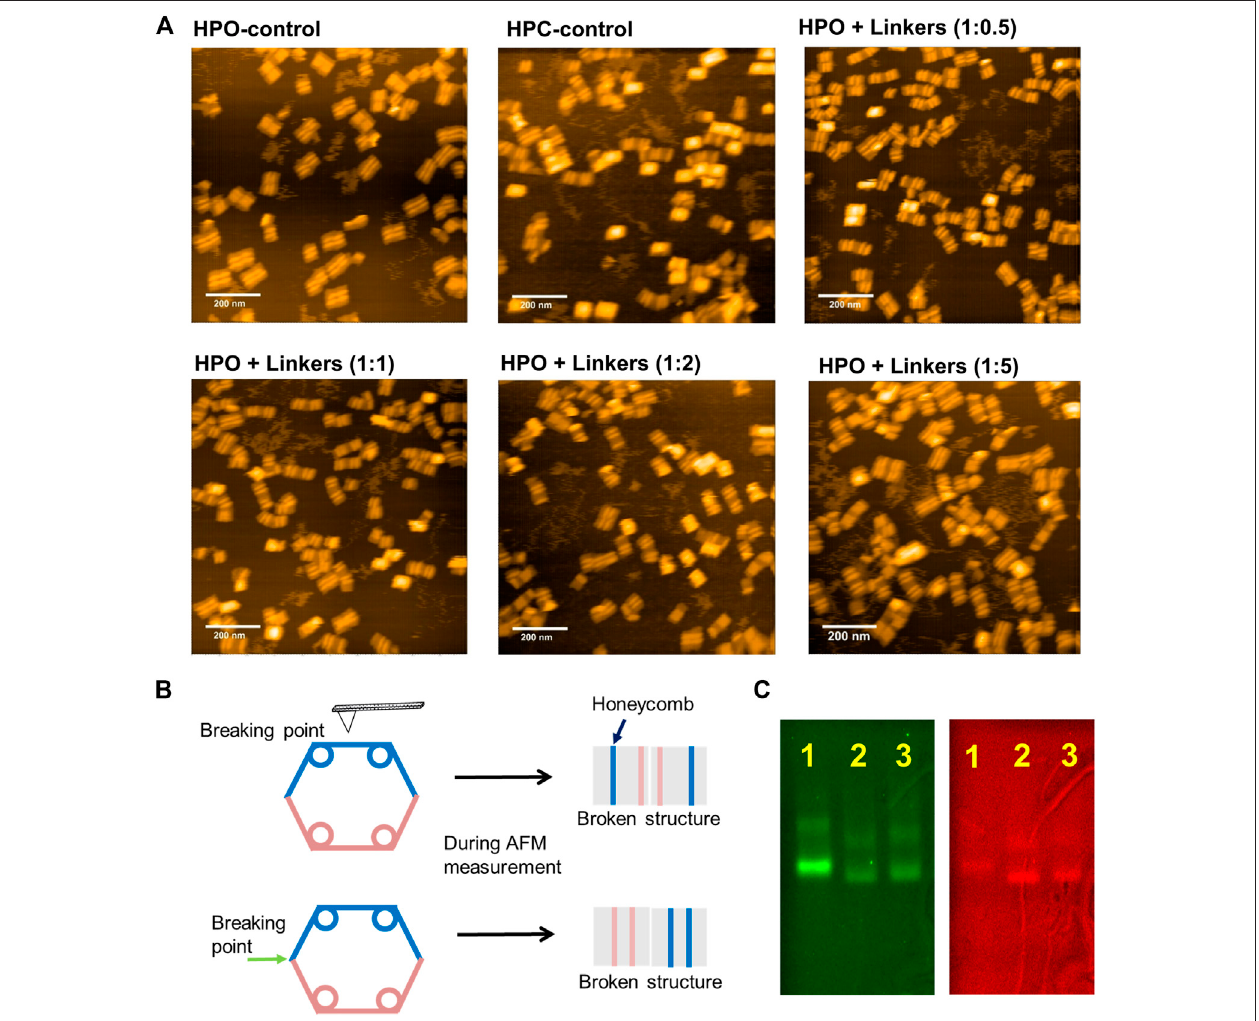
FIGURE 3 | Characterization of the closing ef fi ciency of DNA scaffold by AFM images and agarose gel electrophoresis. (A) AFM images of HPO-control, HPC- control,andHPOclosedbylinkersintheindicatedmolarratioafter12 hincubationat25 ° C.TheclosingyieldsofHPO+linkers(1:0.5),HPO+linkers(1:1),HPO+linkers (1:2), and HPO + linkers (1:5) were estimated to be 73% (124/169), 86% (174/203), 81% (116/143), and 75% (103/138) by AFM images, respectively. (B) A schematic representation of the closed structures systematically broken by the AFM cantilever during measurement (details were shown in Supplementary Figure S3 of supporting information). Images corresponding to the systematically broken structures were included to estimate the yield of closed structure. (C) Agarose gel electrophoretic analysis ofthe DNA scaffolds. Left: Cy3 channel ( λ ex (cid:2) 532 nm, λ em (cid:2) 605 nm); right: FRET channel ( λ ex (cid:2) 532 nm, λ em (cid:2) 695 nm); Lane 1: HPO-control; Lane 2: HPC-control; Lane 3: HPO + linkers (1:1, after 12 h hybridization at 25 ° C). Agarose gel electrophoretic analyses were conducted with 1.5% agarose gel in 1 × TAE (pH 8.0) containing 12.5 mM MgCl 2 at 100 V for 6 h.